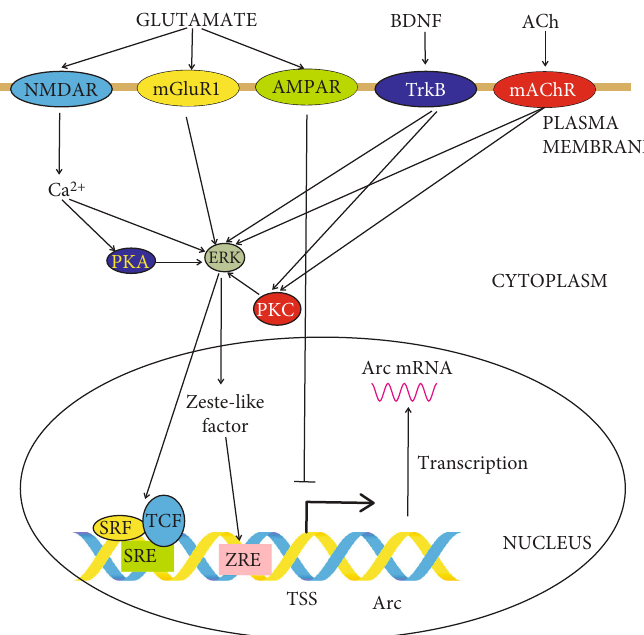
Figure 3: Regulation of the transcription of the activity-regulated cytoskeleton-associated protein (Arc) gene. Some known and putative pathways are presented only. Basic low-level Arc transcription can be further decreased by the activation of α -amino-3-hydroxy-5- methyl-4-isoxazolepropionic acid receptor (AMPAR). Arc transcription is promoted by signaling through the NMDAR (N-methyl-D- aspartate receptor), mGluR (group 1 metabotropic glutamate receptor), TrkB (tropomycin-receptor kinase B), and mAChR (muscarinic acetylcholine receptor) signaling pathways through the interaction with several downstream kinases, including ERK (extracellular-signal- regulated kinase), PKA (protein kinase A), and PKC (protein kinase C). ERK increases Arc transcription through its coactivator TCF (ternary complex factor) binding to SRE (serum response element) in the Arc promoter. ERK may also increase Arc transcription through its Zeste-like factor directly interacting with ZRE (Zeste-like response element) in the Arc promoter. The transcription start site (TSS) and direction of transcription are marked by the bold arrow above the Arc gene. Ach: acetylcholine; BDNF: brain-derived neurotrophic